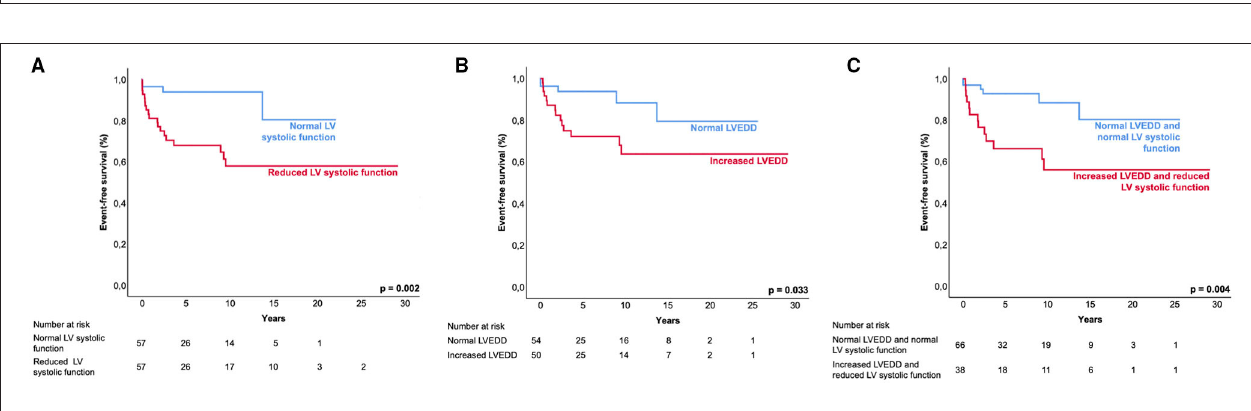
FIGURE 4 | Event-free survival of LVNC patients. Kaplan-Meier analysis shows the event-free survival to the combined endpoint of mechanical circulatory support, heart transplantation, survived sudden cardiac death, and all-cause death. Event-free survival between patient groups. (A) , normal LV systolic function and reduced LV systolic function; (B) , normal LVEDD and increased LVEDD; and (C) , ‘normal LVEDD and normal LV systolic function’ and ‘increased LVEDD and reduced LV systolic function’. LV, left ventricular; LVEDD, left ventricular end-diastolic